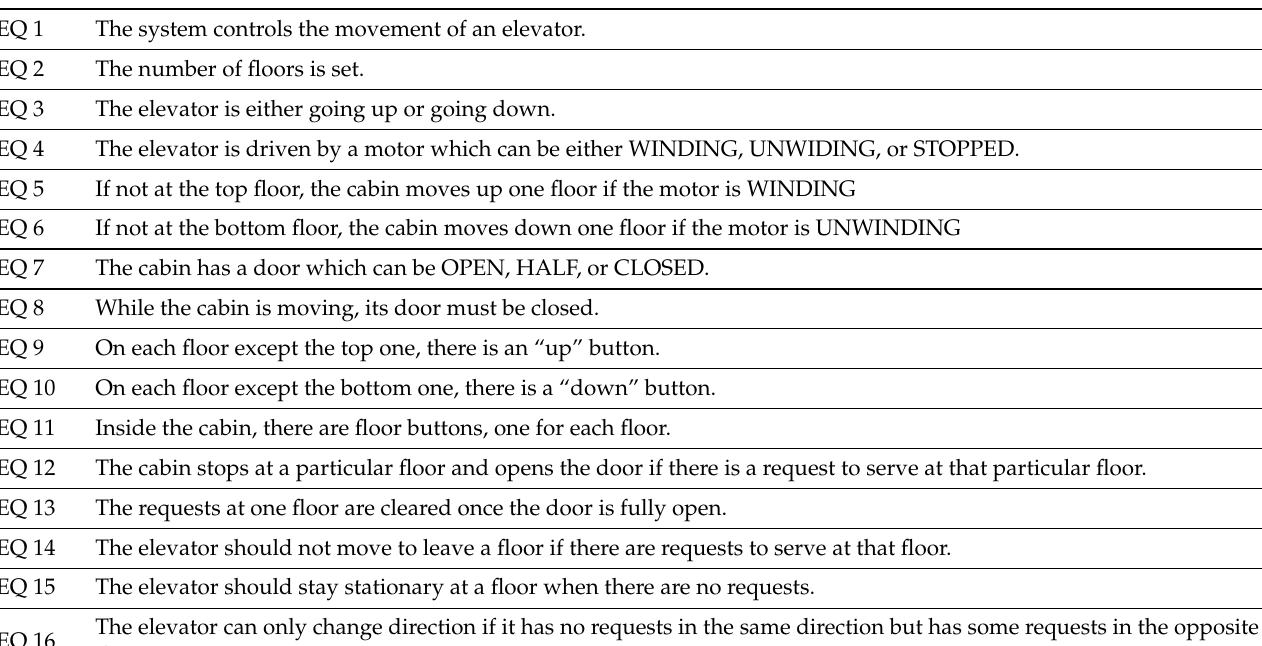
Figure 3. An elevator system model with 0 to N floors, including a car, cables, an elevator machine, controls drive, cabin buttons and floor buttons. Table 2. System